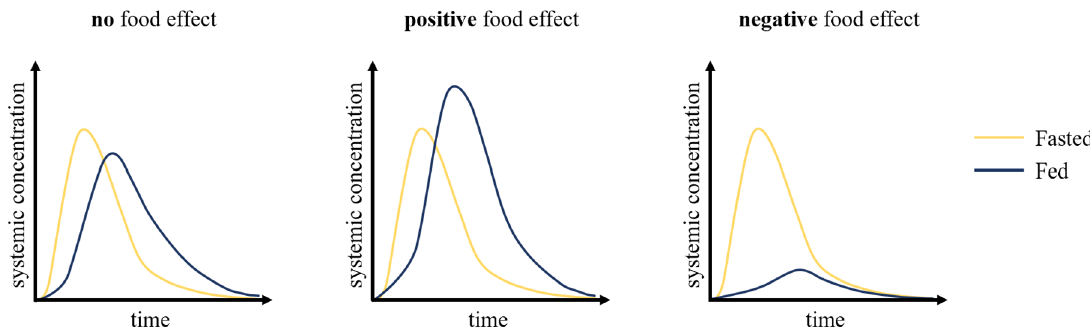
Figure 1. Drug pharmacokinetic profiles for the fasted and fed states. In the cases of no food effect, changes in the pharmacokinetic profile are minor and within the normal variations observed following oral administration. Positive food effects are associated with increases in systemic drug exposure and negative food effects are associated with decreases in drug exposure. Adapted from reference [3].